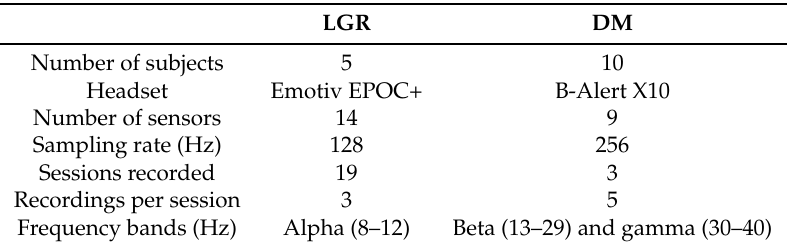
Table 1. Features of the datasets analyzed with the proposed